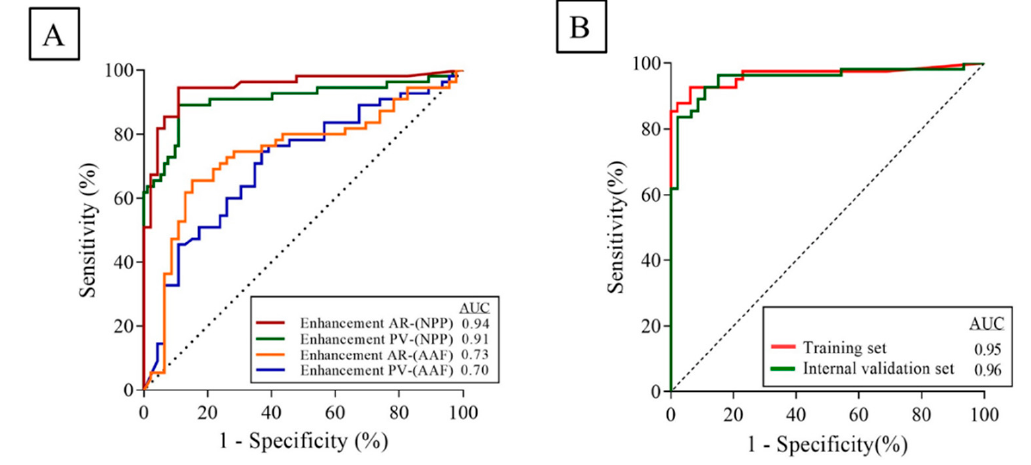
Figure 1. ( A ) Univariate logistic regression analysis of the measured quantitative enhancement values versus the qualitative delta scoring using the training data set. ( B ) Multivariate logistic regression analysis using the model identified measurements (q-delta), in training D1 ( n = 101), and internal validation D2 ( n = 90). Abbreviations: (AR)-NPP: enhancement at the arterial phase normalized to normal pancreas parenchyma; (PV)-NPP: enhancement at the portovenous phase normalized to normal pancreas parenchyma; (AR)-AFF: enhancement at the arterial phase normalized to anterior abdominal fat; (PV)-AFF: enhancement at the portovenous phase normalized to anterior abdominal fat. A backward elimination process identified (1) NE at the AR phase while referencing NPP ( p = 0.03) and (2) NE at the PV phase while referencing NPP ( p = 0.007) as the most significant parameters and